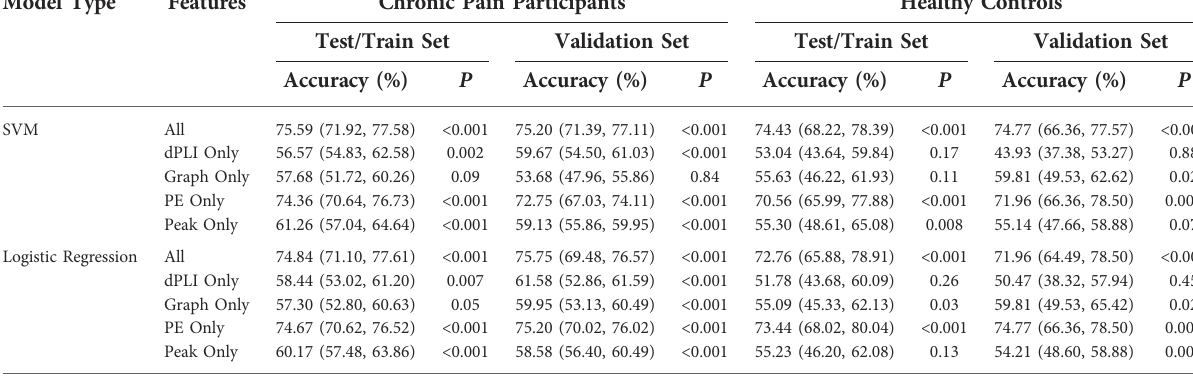
TABLE 1 Test/train and validation set accuracies for the radial SVM and logistic regression models presented for the chronic pain and healthy controls groups. Model